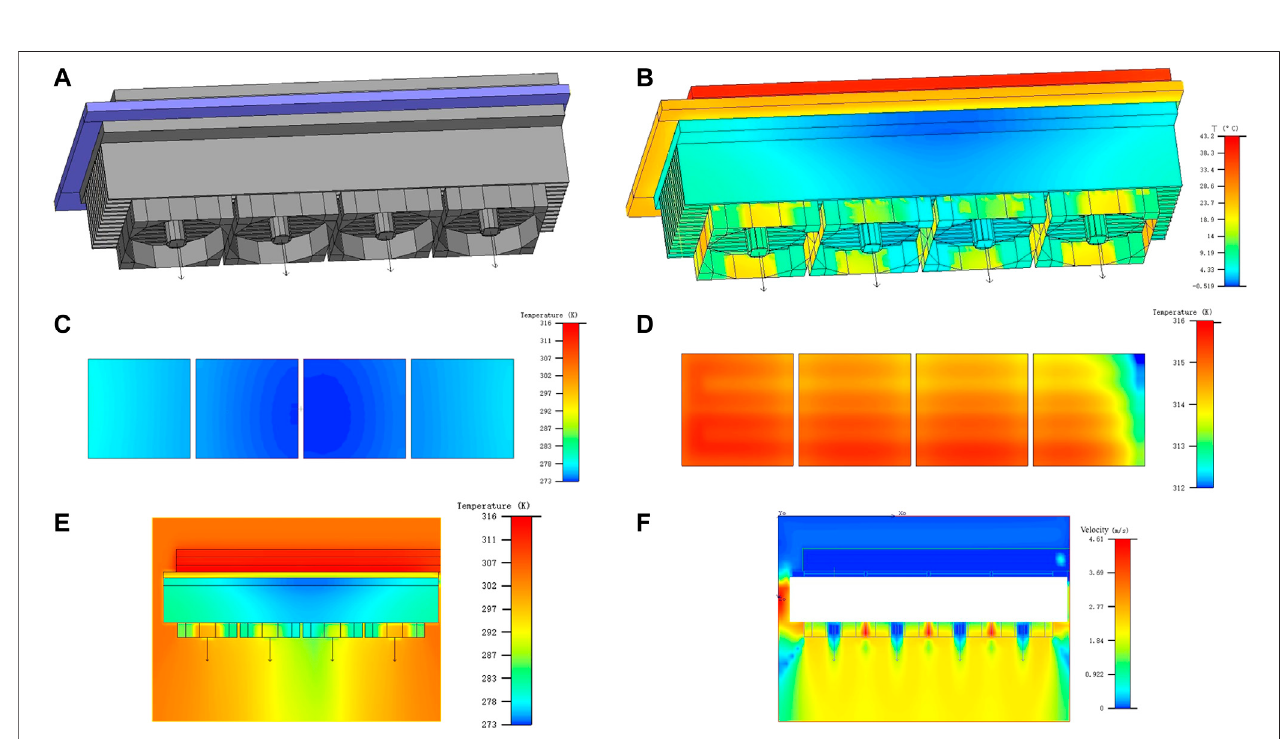
FIGURE 7 | Performance analysis of thermoelectric cooling